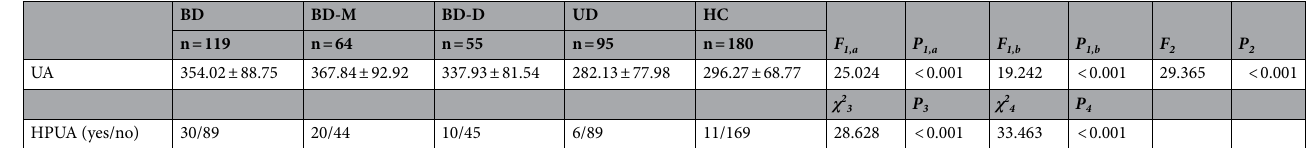
Table 2. UA levels of participants in AS (mean ± SD, μmol/L). UA, uric acid; HPUA, hyperuricemia; BD-M, mania/hypomania; BD-D, bipolar depression; UD, unipolar depression; HC, healthy control; SD, Standard deviation. 1 , age, sex, history of smoking, family history, age of onset, mood episode numbers, duration of disease, whether with psychotic symptom and lipid indices as covariates between BD and UD groups. 2 , age, sex, history of smoking and lipid indices as covariates among 3 groups. 3 , compare the number of participants with HPUA among BD, UD and HC groups. 4 , compare the number of participants with HPUA among BD-M, BD-D, UD and HC groups. a , comparison between BD and UD groups. b , comparison among BD-M, BD-D and UD groups.